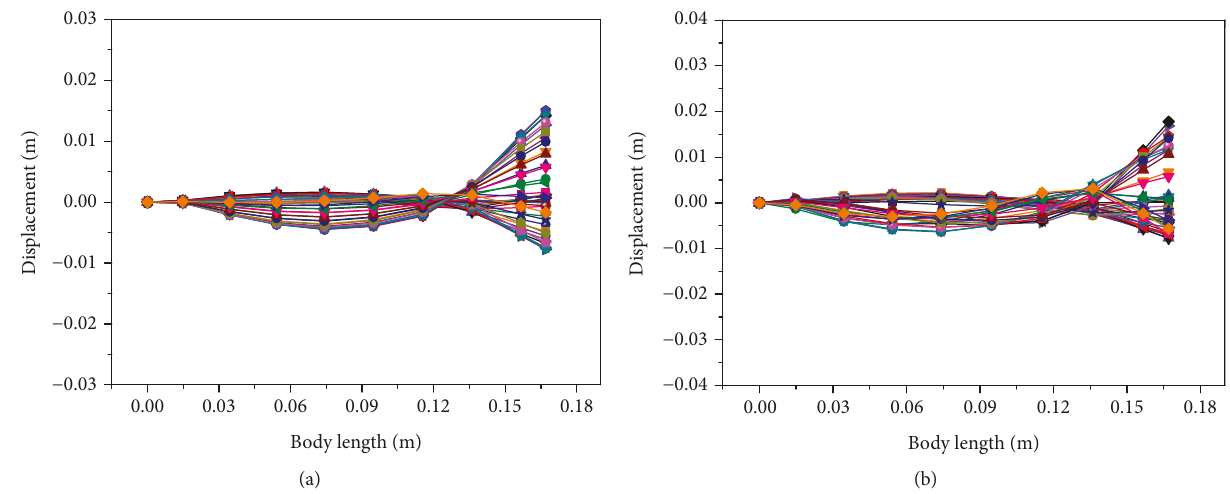
Figure 15: Propulsion modes of soft robotic fi sh in one cycle at 3Hz in the motion of turning left. (a) Results in sine waveform. (b) Results in square